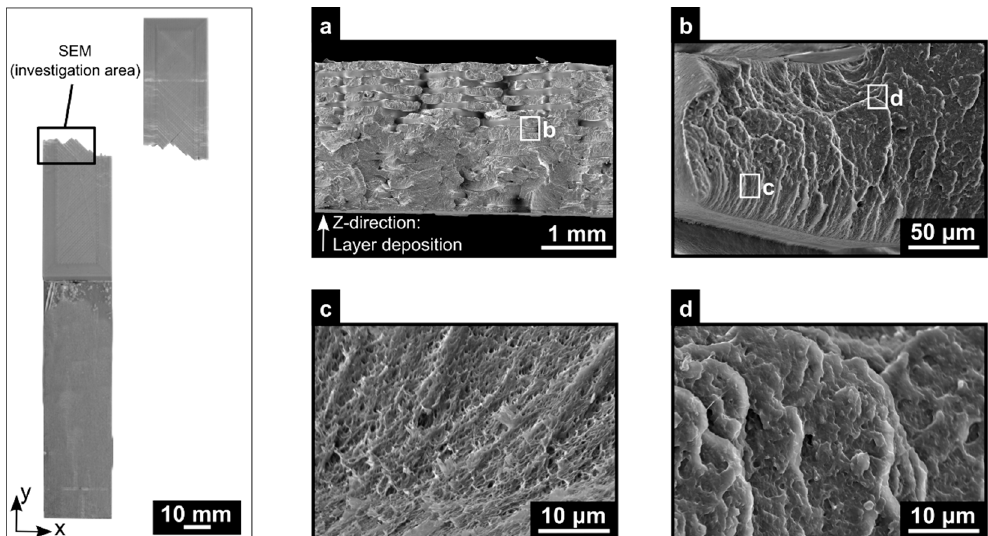
Figure 25. Aluminum 2024 ‐ T3/ABS hybrid joint failed joint under a quasi ‐ static lap shear test and SEM images of the fracture surface ( a ) at low magnification in the cross ‐ section with the direction of deposition along the polymer thickness, ( b ) high magnification of the road fractured, ( c ) fibrils in pulling direction, and ( d ) brittle failure (PT: 280 °C, RT: 0.1 mm; DS: 60 mm/s; AC: 25 wt.%; NC: 12).